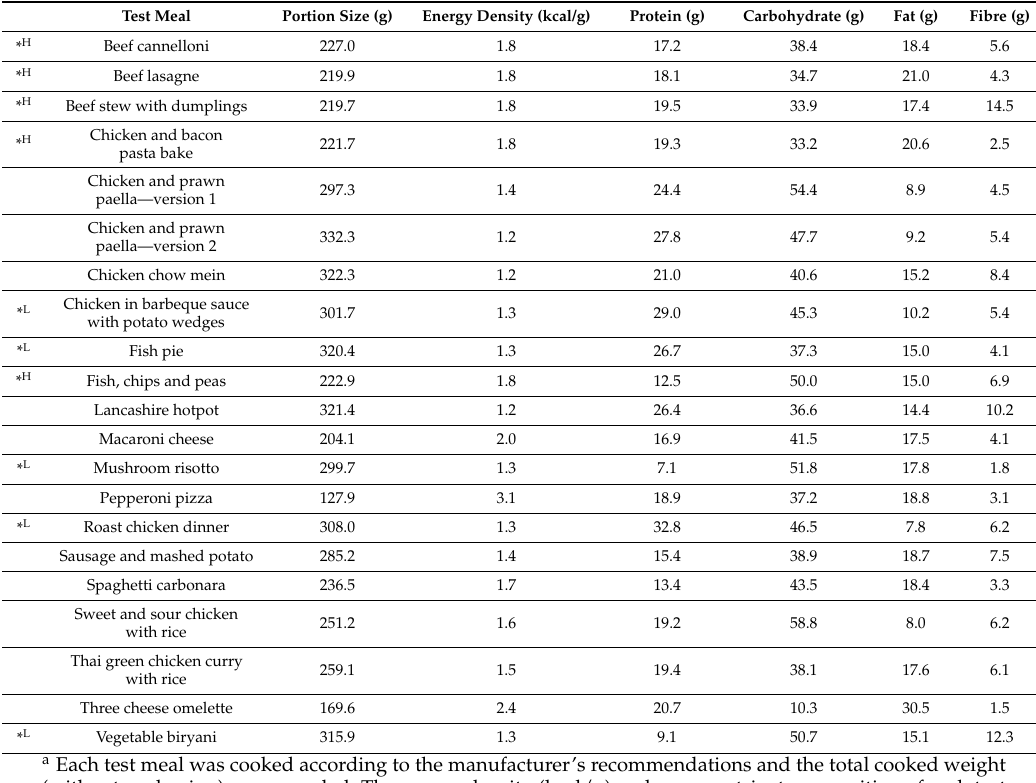
Table 1. Portion size and macronutrient composition for the 400-kcal portions of the 20 test meals a . Respectively, * L and * H indicates that the test meal belongs to the low- and high- energy-dense subgroups. Test Meal Portion Size (g) Energy Density (kcal/g) Protein